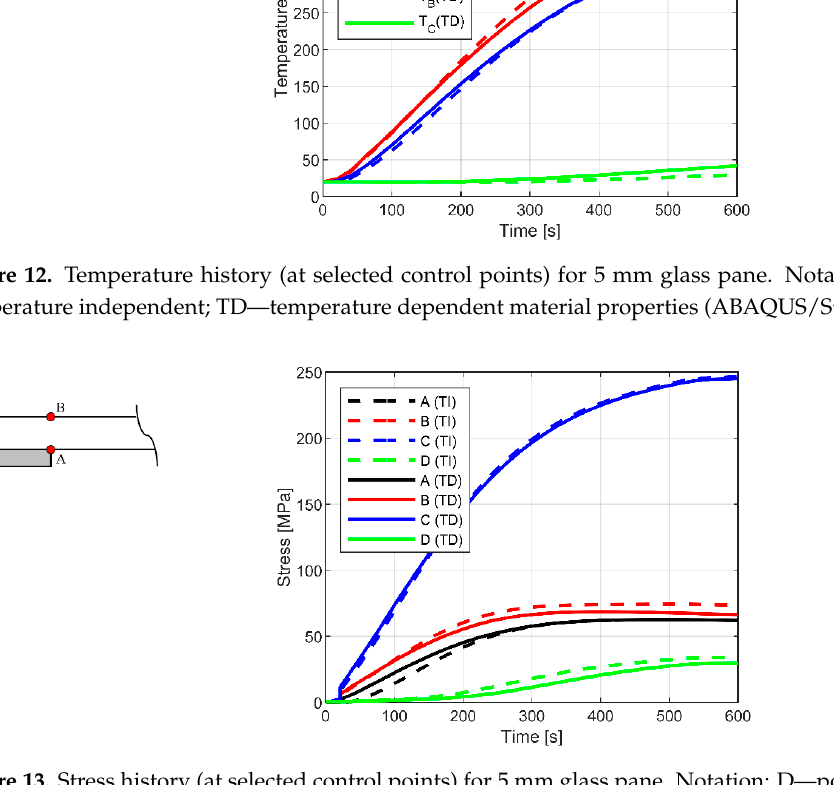
Figure 15. Maximum principal stress sensitivity study at selected control points (ABAQUS/Stand ‐ ard). 7. Failure Detection 7.1. Thermal Exposure Following the discussion of available methods (Section 4), the failure condition was first detected for the glass panel under thermal exposure only. To this aim, both the TEMP and STRESS approaches were taken into account, under the assumption of TI and TD ma ‐ terial properties for glass. The typical result is shown in Figure 16, in the form of failure limit condition as a function of the exposure time. The figure shows the overall trend of the failure condition prediction, where the limit value of y ‐ axis “1” represents the nominal failure of the panel (depending on the assumed TEMP or STRESS approaches). Both the TEMP and STRESS